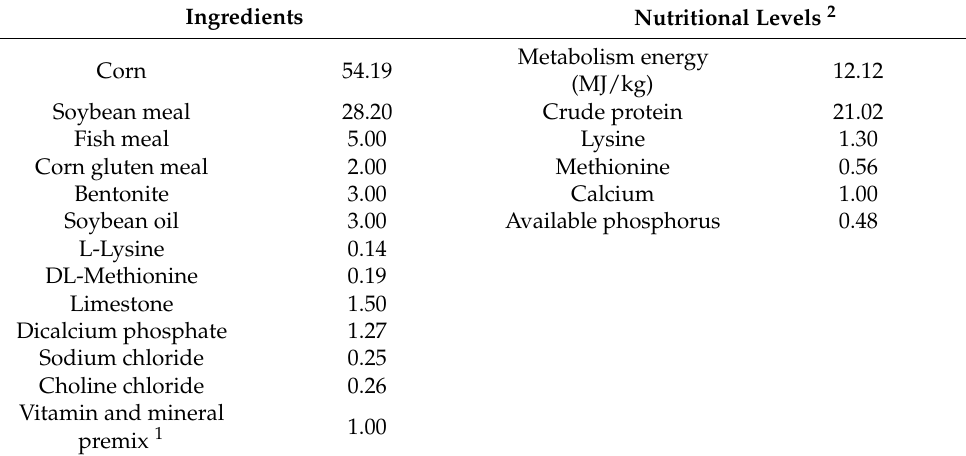
Figure 1. Experimental scheme of DSS-induced enteric inflammation in broilers. Table 1. Ingredients and Nutritional Level of the Basal Diets (%).